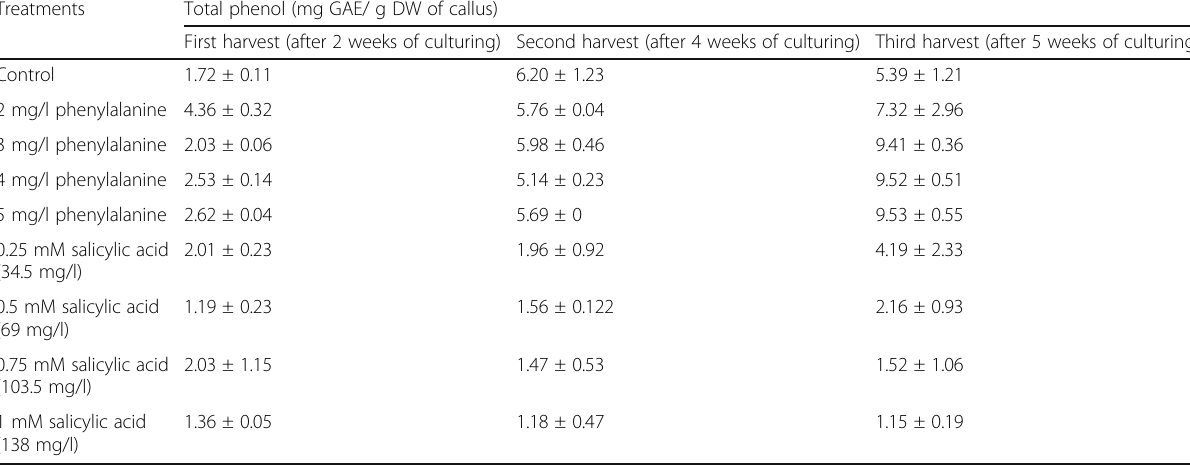
Table 1 Total phenols content in gardenia calli cultures cultured on MS media contained different concentrations of phenyl alanine or salicylic acid during the three harvested periods of culturing Treatments First harvest (after 2 weeks of culturing) Second harvest (after 4 weeks of culturing) Third harvest (after 5 weeks of